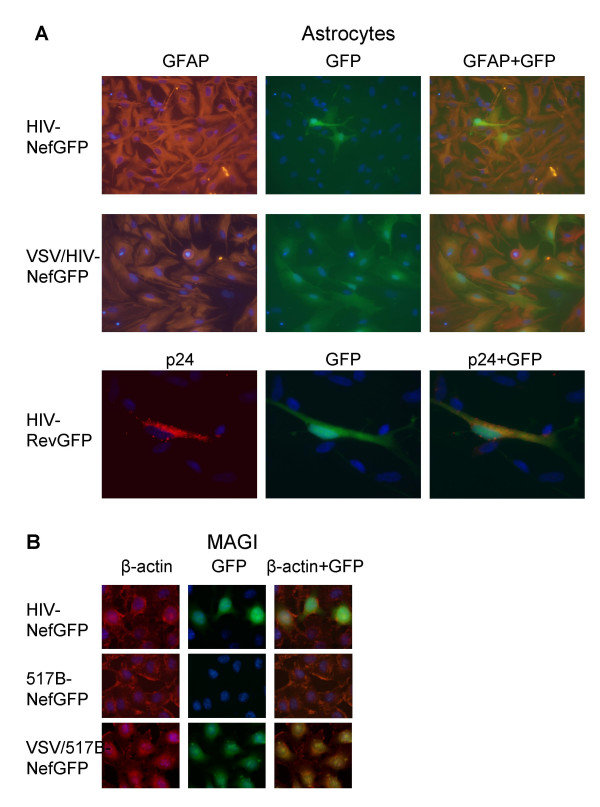
Expression of HIV-1 regulatory and structural genes by infected HFA and control cells. A) HFA were infected with VSV-G pseudotyped NL4-3 encoding a NefGFP fusion protein (first row), with native NL4-3 encoding NefGFP (second row) or encoding RevGFP (third row). Two days after infection HFA were stained using specific antibodies for GFAP (first and second rows) or p24 (third row) and with DAPI and Texas Red-labeled secondary antibodies. Images of red and green fluorescence were superimposed (third column). B) MAGI cells were infected with NL4-3 encoding NefGFP (first row), or fusion incompetent 517B encoding NefGFP (second row), or 517B-NefGFP pseudotyped by VSV-G (third row). Two days after infection cells were stained with anti-actin, DAPI, and Texas Red-labeled secondary antibody and images of red and green fluorescence were superimposed (third column).